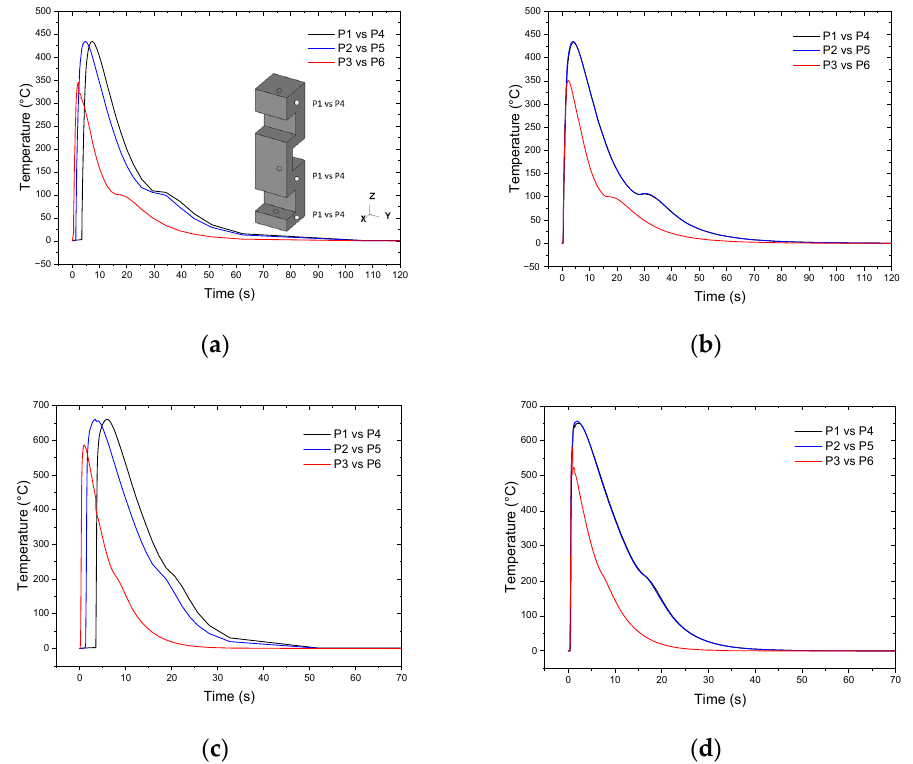
Figure 6. Temperature gradient ( ∆ T) between surface and core points during cooling of AISI 4340: ( a ) VOQ; ( b ) H-OQ; ( c ) V-WQ; and ( d )H-WQ.